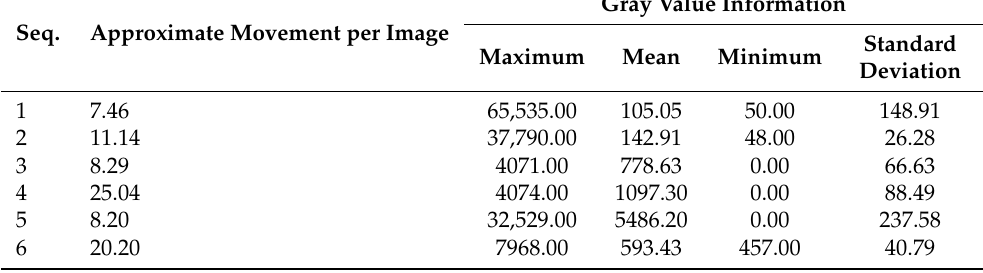
Table 2. Information of images in